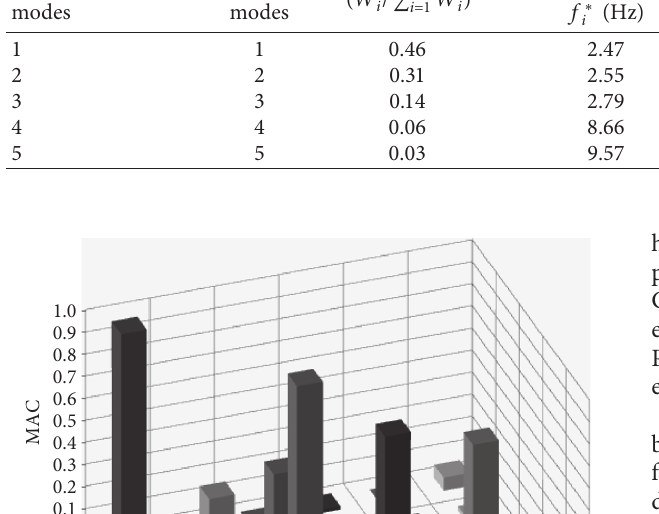
Table 8: Results of the modal decomposition analysis assuming w / d � 0.24 and comparison with experimental outcomes. Experimental modes